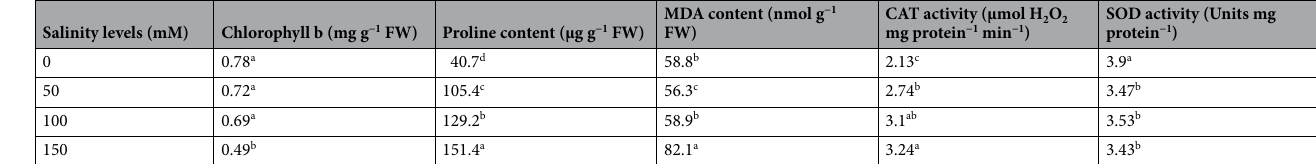
Table 5. Mean comparisons for the effects of salinity (0, 50, 100, and 150 mM NaCl) on chlorophyll b content, proline, and MDA content as well as on SOD and CAT activity of Tanacetum balsamita plants grown hydroponically in perlite. Significant differences among salinity treatments are indicated by the different Latin letters according to Duncan’s multiple range test.